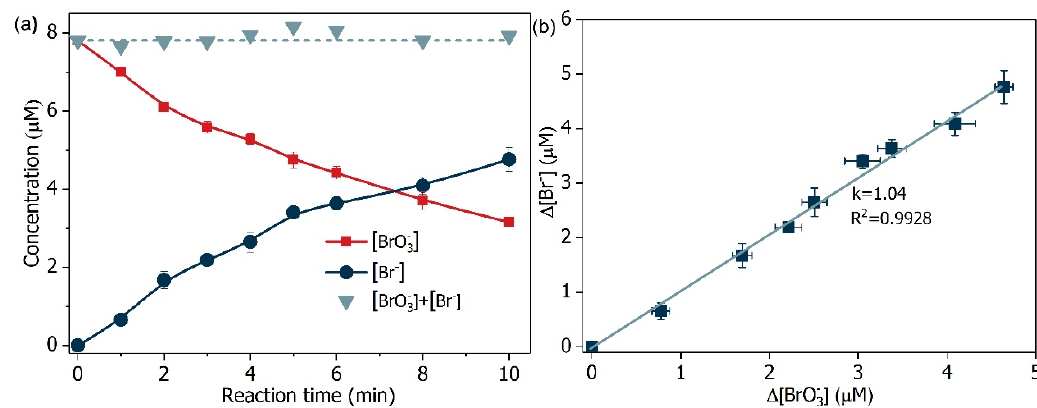
Figure 12. ( a ) Mass balance of bromine element and ( b ) relationship of bromate decrease and bromide